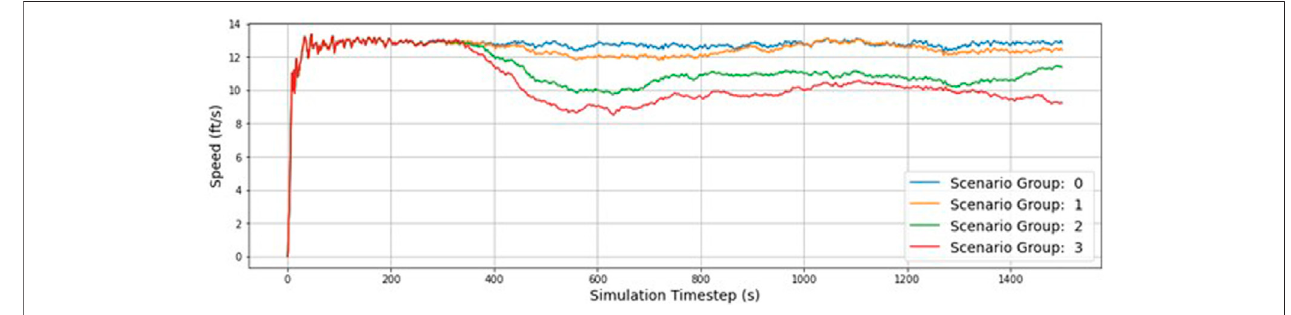
FIGURE 3 | Vehicle speed per time step — DOS groups.